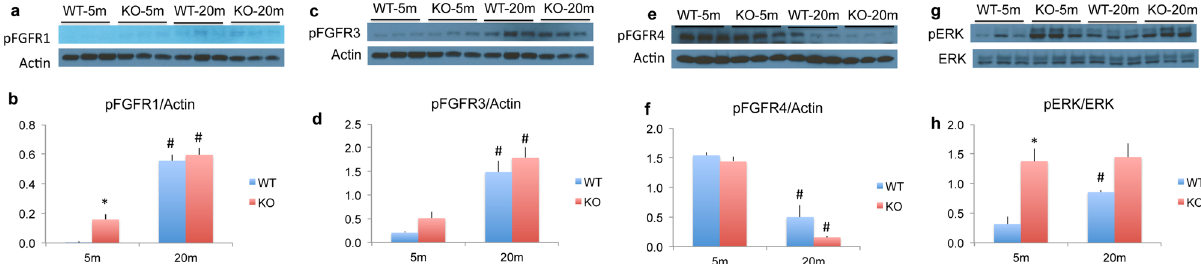
Figure 8. Expression of FGFR protein and MAPK/ERK signaling in skeletal muscle from WT and Fgf2KO mice. Young (5 m) and old (20 m) WT and Fgf2KO mouse triceps muscles were isolated and total protein extracted for western blotting. ( a ) phosphoFGFR1 Western blot and ( b ) quantification. ( c ) phosphoFGFR3 Western blot and ( d ) quantification. ( e ) phosphoFGFR4 Western blot and ( f ) quantification. ( g ) phosphoERK and total ERK Western blot and ( h ) quantification . ( a , b ) phosphoFGFR1; ( c , d ) phosphoFGFR3 were significantly increased, while ( e , f ) phosphoFGFR4 was significantly decreased in old muscle of both genotypes. ( g , h